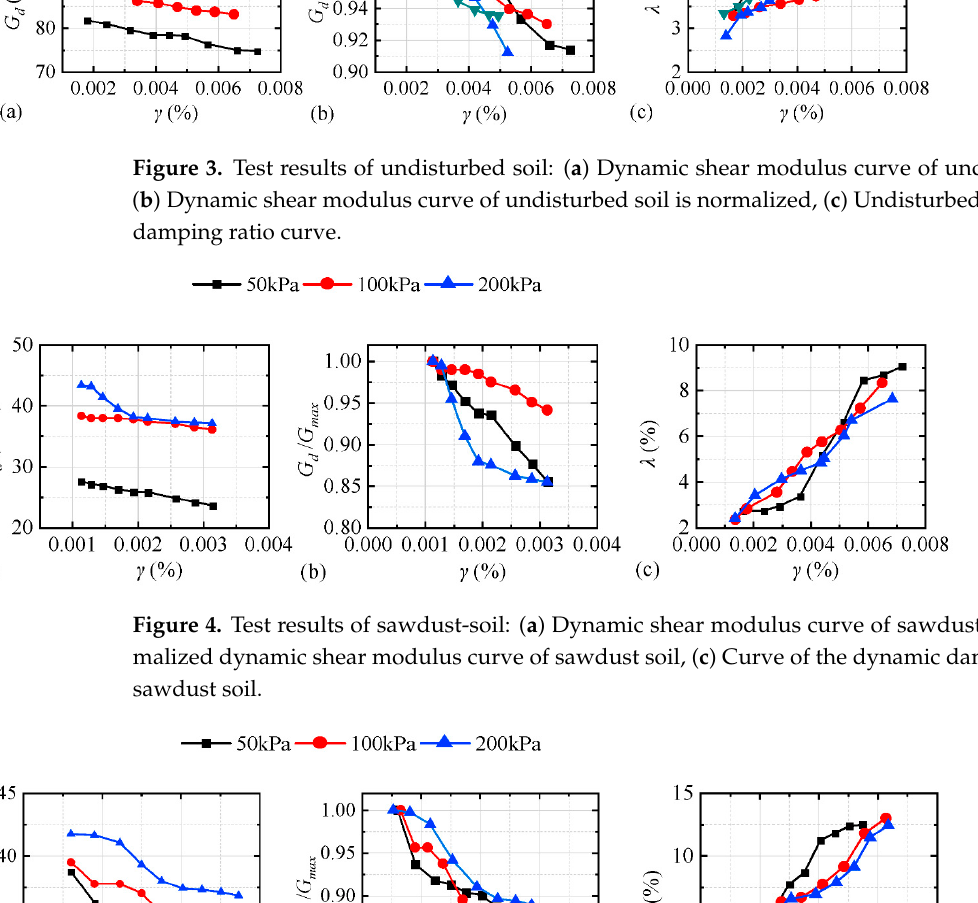
Figure 6. Test results of rubber granular soil:; ( a ) Dynamic shear modulus ( b ) Normalized dynamic shear modulus, ( c ) Dynamic damping ratio.